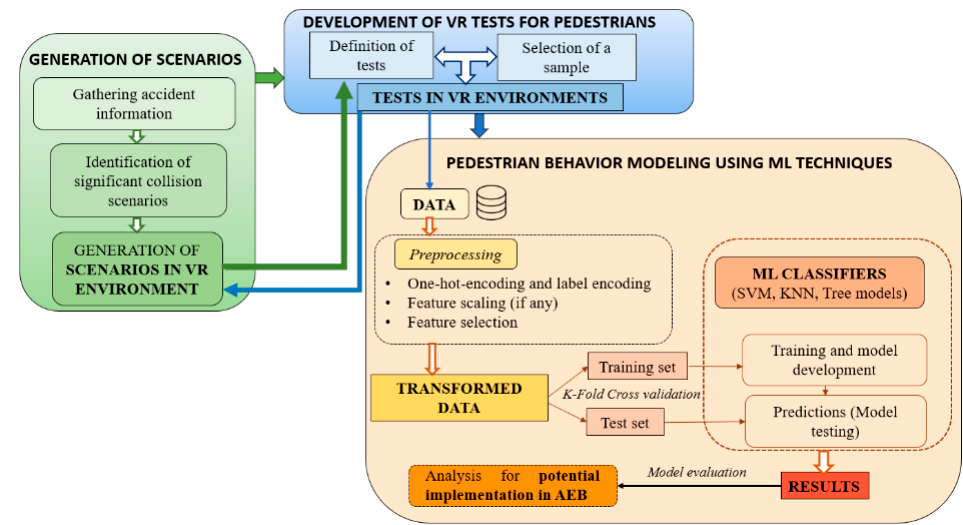
accidents under specific conditions (green block), the definition of tests, the choice of a sample of subjects for testing in virtual environments (blue block), and the generation of Machine Learning classification models to define pedestrian behavior and its relationship with the possibility of being hit by a car in potential collision situations (orange block).